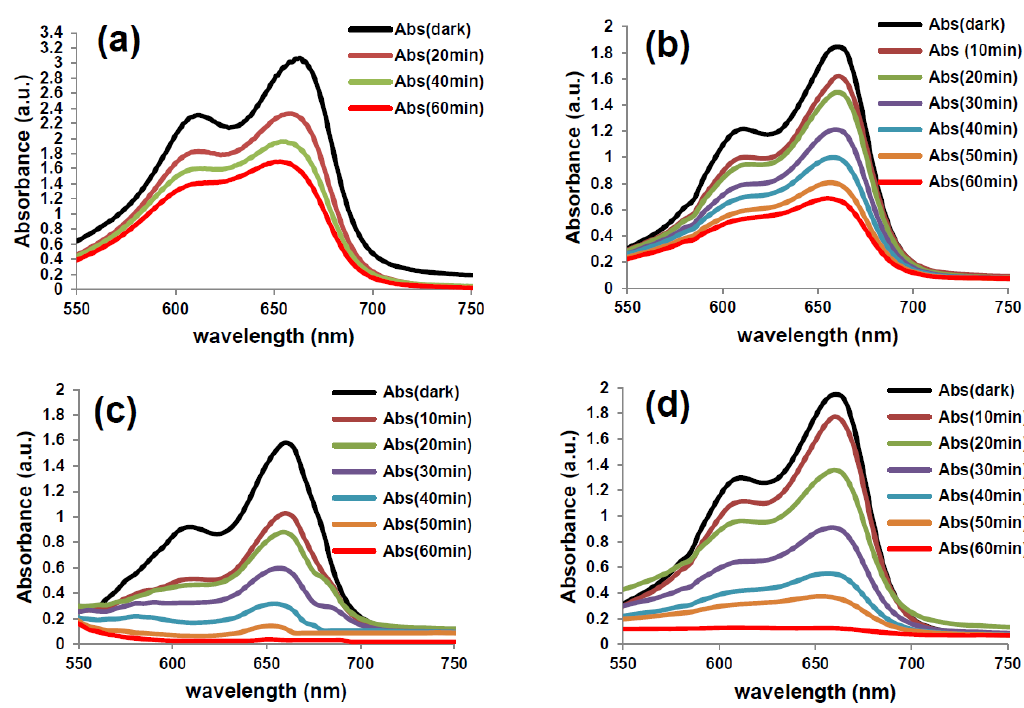
Figure 5: UV-Vis photocatalytic absorption spectrum of MB recorded by TiO 2 photocatalyst prepared with various intervals. (a) pure TiO 2 nanofibers (b) TiO 2 -0.25CdS (c) TiO 2 -0.5CdS (c) TiO 2 -1CdS composite nanofibers. Table 1: Fundamental results for pure TiO 2 and TiO 2 -CdS nanofibers.